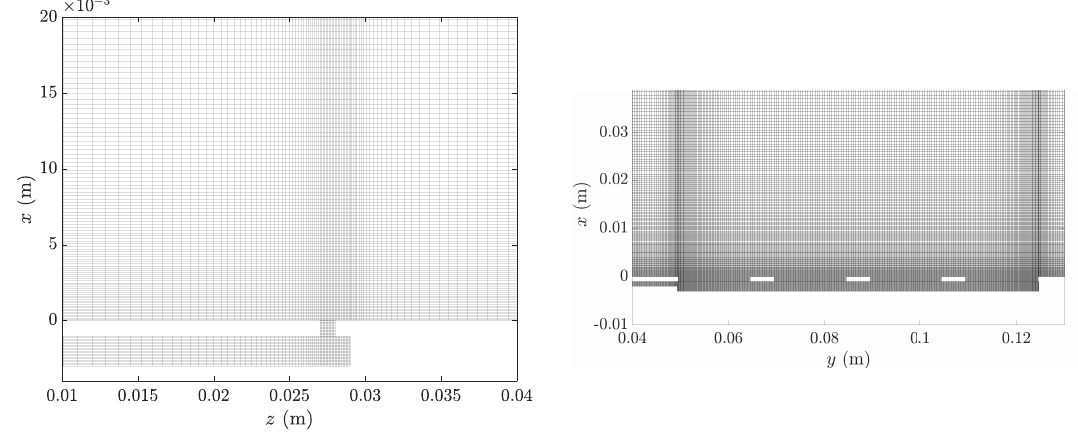
Figure 4. Front ( left ) and side ( right ) view of the mesh used in the numerical simulation, zoomed near the slot exit